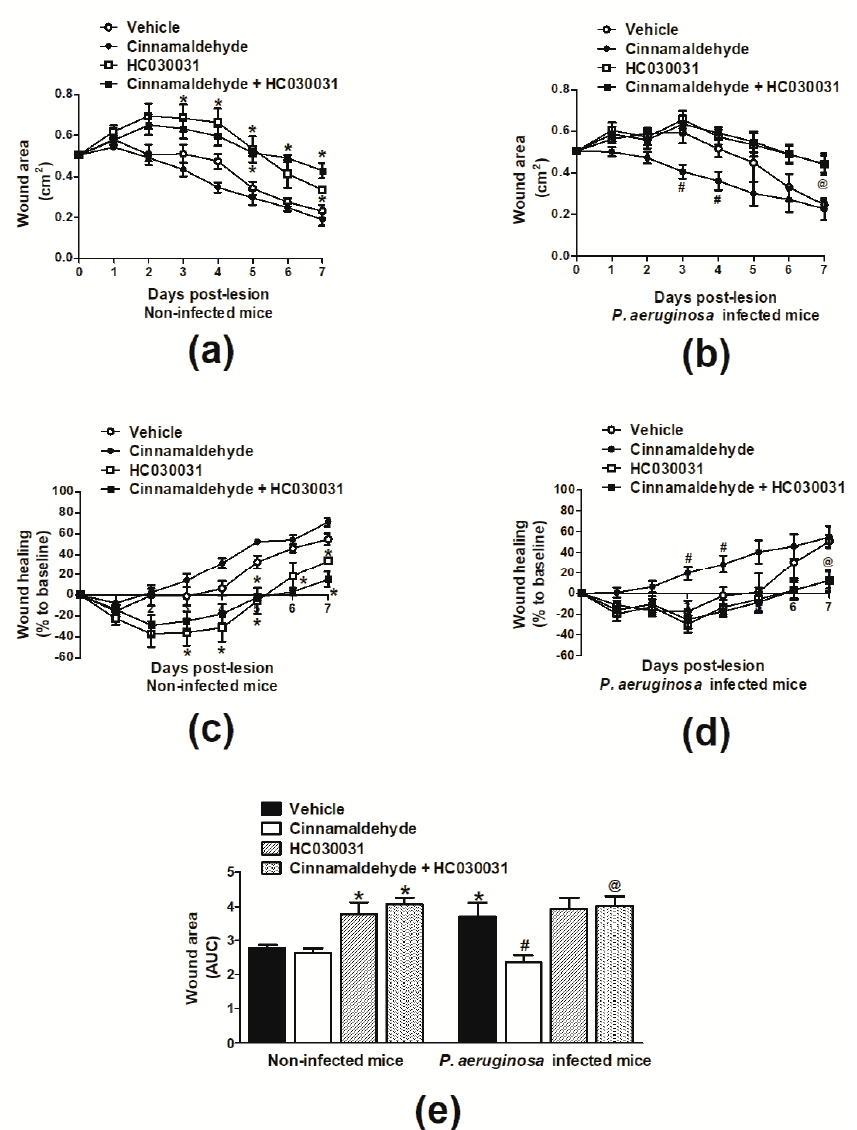
Figure 3. E ff ects of topical cinnamaldehyde or systemic TRPA1 antagonism on wound healing. Figure 3. Effects of topical cinnamaldehyde or systemic TRPA1 antagonism on wound healing. Time course Time course of ( a ) wound area and ( b ) healing in non-infected mice. Time course of ( c ) wound area of ( a ) wound area and ( b ) healing in non ‐ infected mice. Time course of ( c ) wound area and ( d ) healing in P. and ( d ) healing in P. aeruginosa -infected mice. ( e ) Area under de curve (AUC) of wound area over a aeruginosa ‐ infected mice. ( e ) Area under de curve (AUC) of wound area over a seven ‐ day time ‐ course. seven-day time-course. Animals received either sterile saline or P. aeruginosa ATCC 27853 following Animals received either sterile saline or P. aeruginosa ATCC 27853 following skin excision. Cinnamaldehyde skin excision. Cinnamaldehyde (0.5 mg / mL; 30 µ L, n = 6) or 2% DMSO in sterile saline (30 µ L, n = 6) (0.5 mg/mL; 30 μ L, n = 6) or 2% DMSO in sterile saline (30 μ L, n = 6) were topically applied once a day for were topically applied once a day for sevn days. The TRPA1 antagonist HC-030031 (30 mg / kg, i.p., sevn days. The TRPA1 antagonist HC ‐ 030031 (30 mg/kg, i.p., n = 6) or vehicle (8% DMSO in saline, i.p., n = n = 6) or vehicle (8% DMSO in saline, i.p., n = 6) were administered to animals receiving or not 6) were administered to animals receiving or not cinnamaldehyde. * p < 0.05, differs from vehicle ‐ treated cinnamaldehyde. * p < 0.05, di ff ers from vehicle-treated non-infected mice; # p < 0.05, di ff ers from non ‐ infected mice; # p < 0.05, differs from vehicle ‐ treated P. aeruginosa infected mice; @ p < 0.05, differs from vehicle-treated P. aeruginosa infected mice; @ p < 0.05, di ff ers from cinnamaldehyde-treated P. aeruginosa cinnamaldehyde ‐ treated P. aeruginosa infected mice. infected